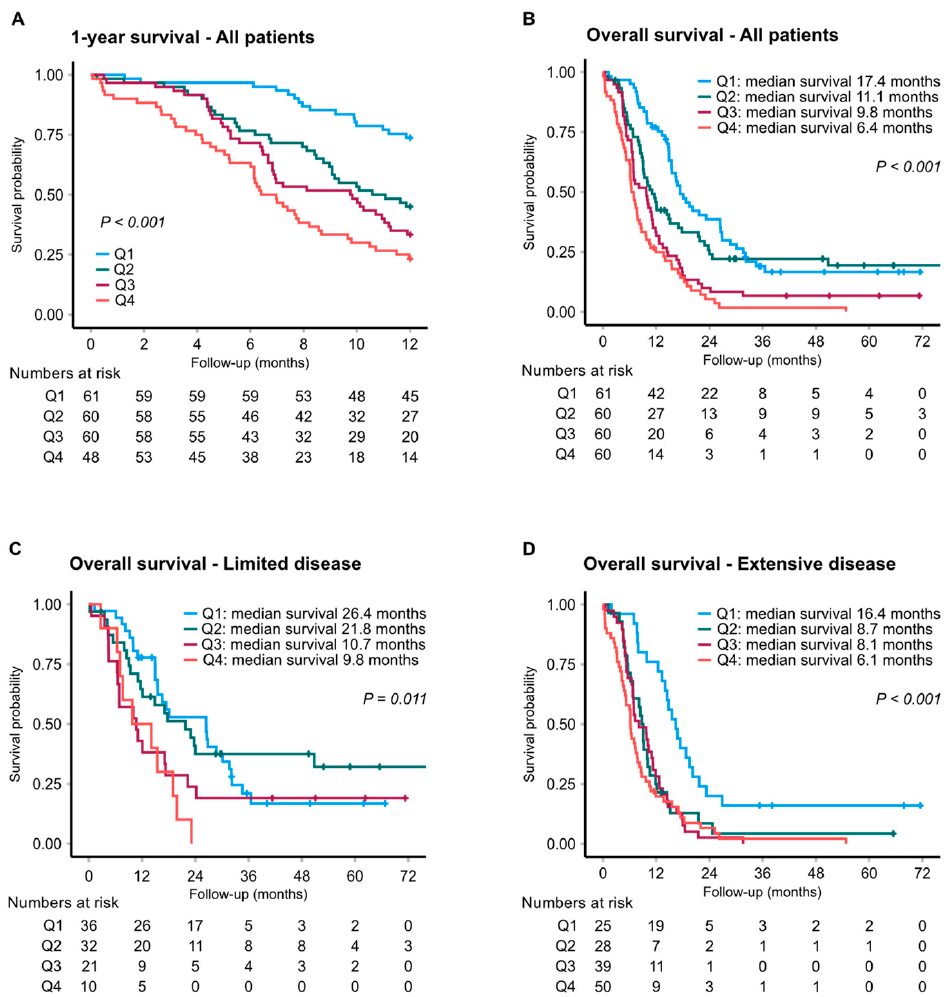
Figure 2. Kaplan–Meier analysis of survival by ST2 levels. One-year survival ( A ) and overall survival for all patients ( B ) and by stage; limited ( C ) and extensive ( D ) disease.